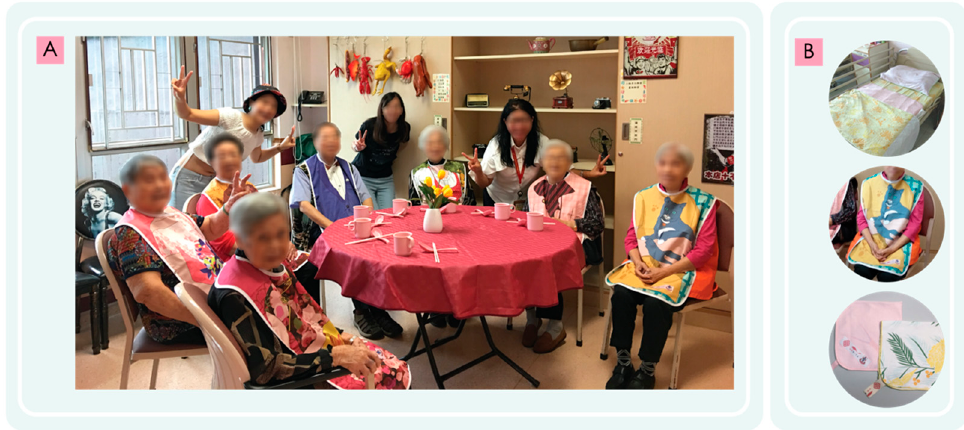
Figure 6. ( A ) A photo showing the elderly of TWGHs wearing the developed apron; ( B ) Photos showing the final